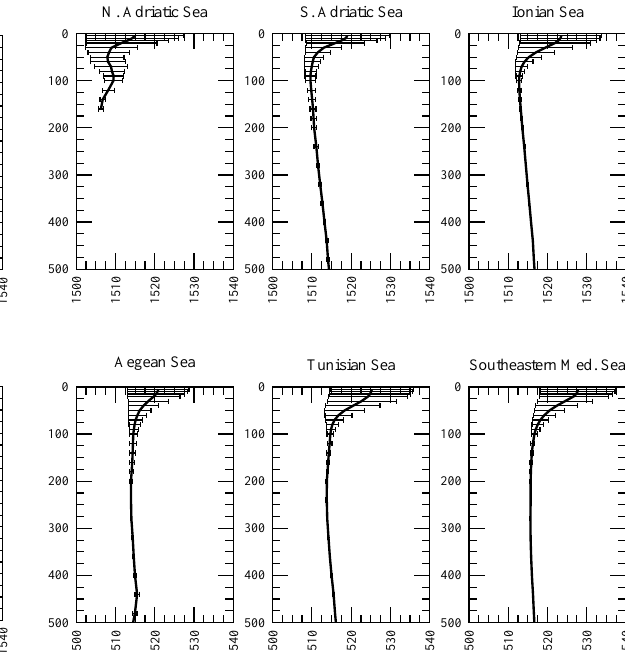
Fig. 10. East Mediterranean: annual mean sound speed profile (m/s) and relative computed temporal standard deviation σ t between a 5 and 500m